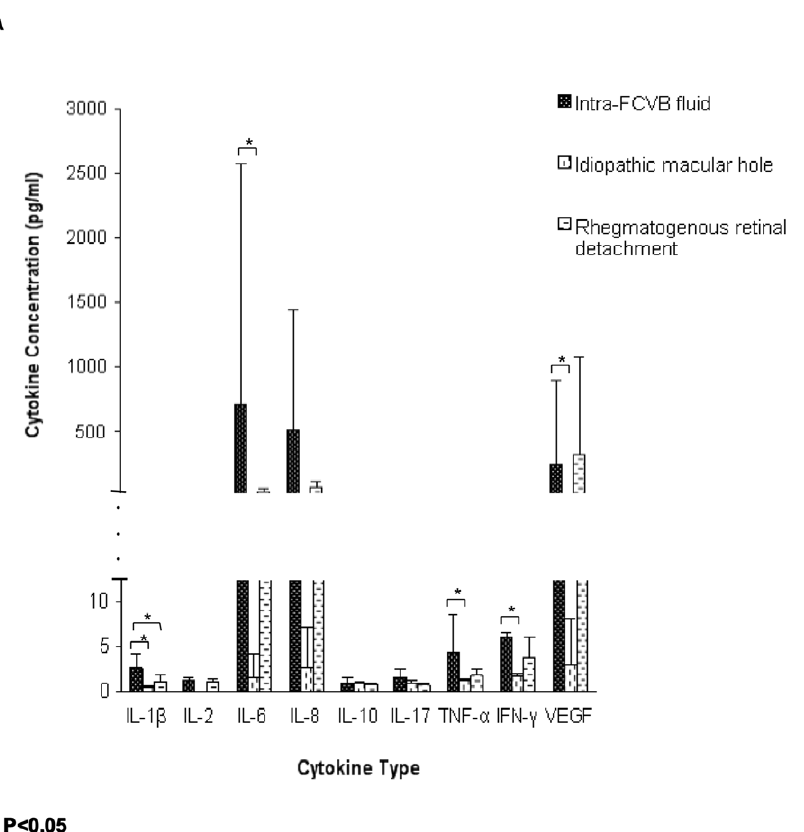
Figure 3. Comparison of nine cytokine concentrations between the intra-FCVB fluid (n=8) and the control groups measured by Multiplex Immunoassay. Compare to the idiopathic macular hole control group, the concentrations of IL-1 b , IL-2, IL-6, TNF- a , IFN- c and VEGF were slightly higher in the intra-FCVB fluid. (IL-2 was below the range of detection sensitivity for samples from idiopathic macular hole patients). The concentrations of IL-8, IL-10 and IL-17 were not statistically significant different compared with the idiopathic macular hole patients. Compared to the rhegmatogenous retinal detachment control group, most cytokines concentrations in the intra-FCVB fluid were not statistically significant different, except IL-1 b .